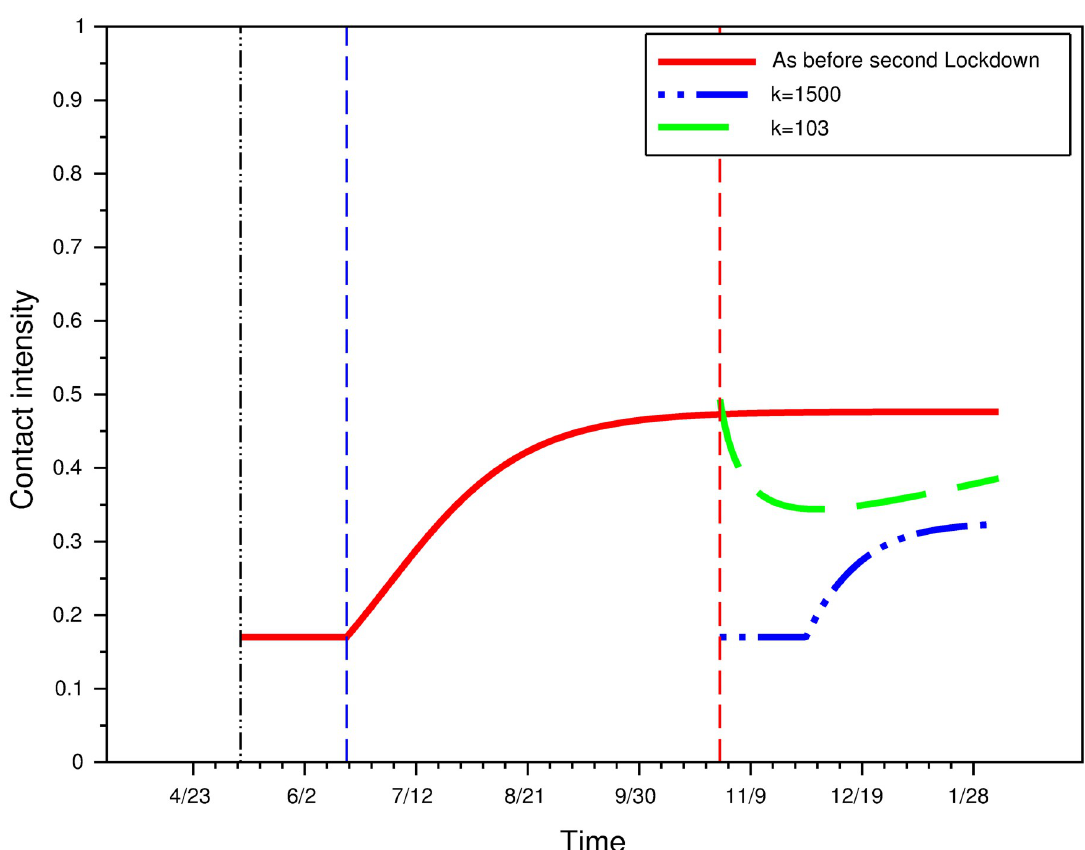
Fig 10. Contact intensity under various perception